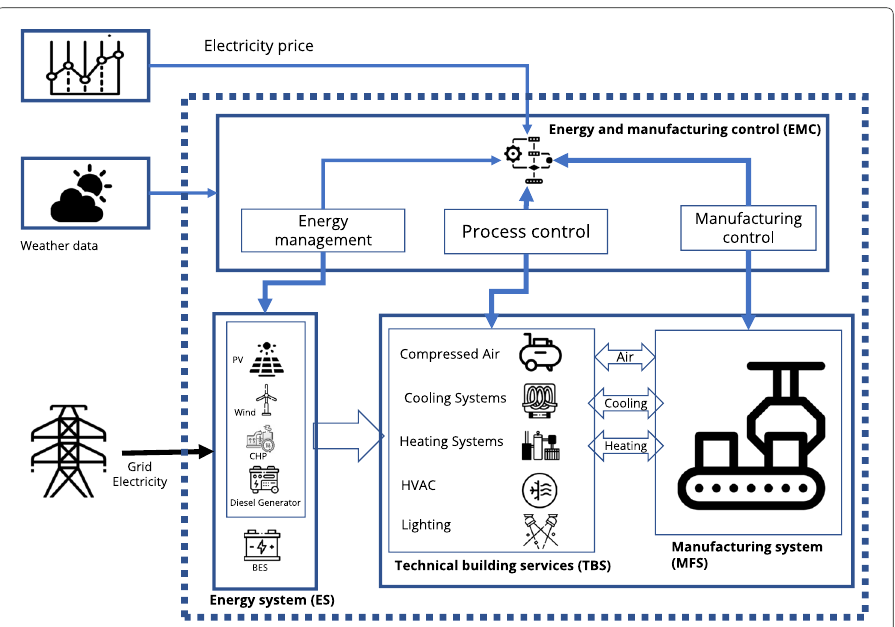
Fig. 1 A generic representation of industrial enterprise for energy flexibility modeling